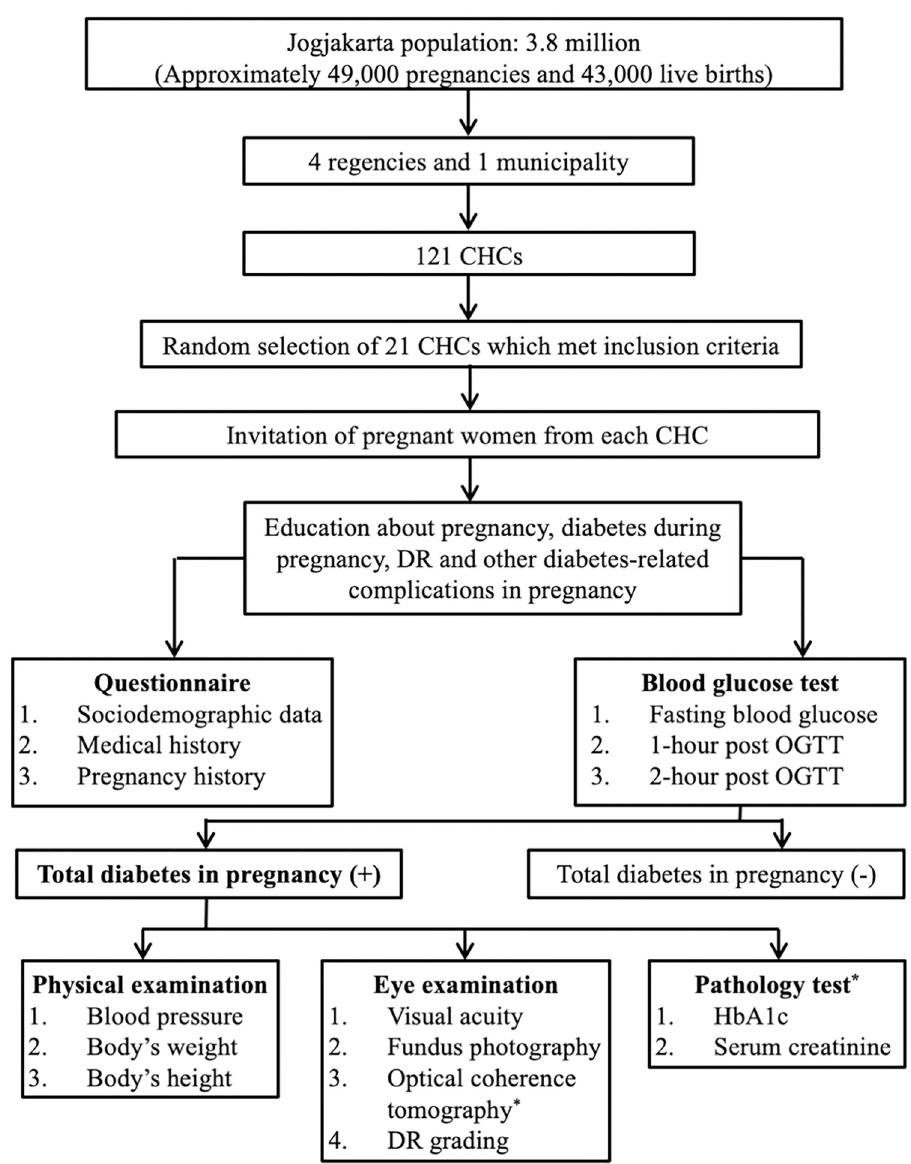
Fig 1. Jogjakarta Diabetic Retinopathy Initiatives in Pregnancy (Jog-DRIP) study design. CHC, community health center; DR, diabetic retinopathy; HbA1c, glycated hemoglobin; OGTT, oral glucose tolerance test. � Performed at the Dr. Sardjito General